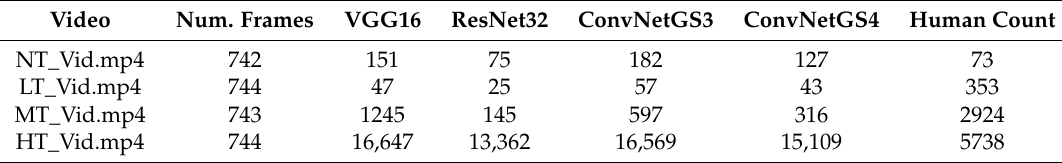
Table 8. Performance of the system on the four evaluation videos NT_Vid.mp4,